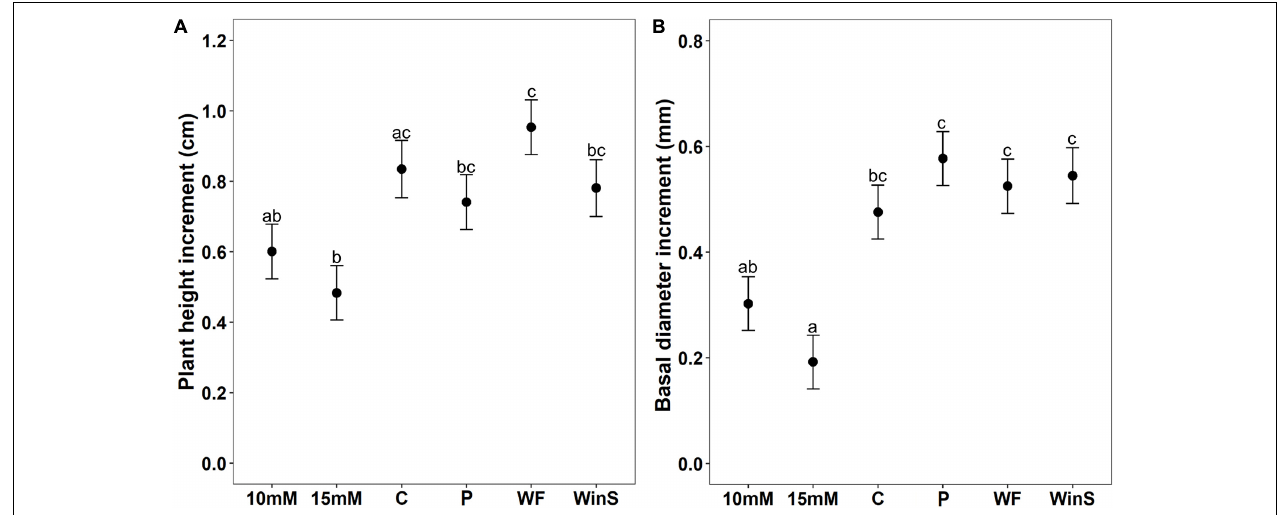
FIGURE 4 | Growth increment of Scots pine ( P. sylvestris ) seedlings receiving different plant defense induction treatments [10 mM MeJA, 15 mM MeJA, undamaged seedlings as controls (C), needle-piercing damage to the stem bark (P), small stem window damage (WinS), and previous weevil feeding damage (WF)] in experiment 2 ( n = 12 per treatment, insect feeding tests were conducted at two time points, 12 and 32 days post-treatment). The growth of seedlings was followed for 32 days post-treatment. (A) Estimated mean height increment (cm ± standard error), and (B) Estimated mean diameter growth (mm ± standard error). Different letters above means indicate statistically significant differences ( P < 0.05) between mean